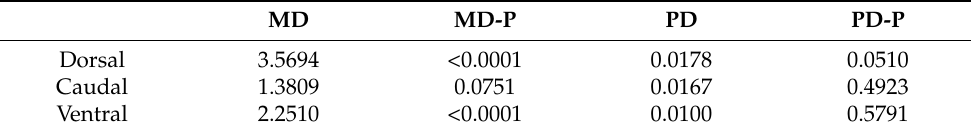
Table 4. Mahalanobis distances and procrustes distances values and p -values.